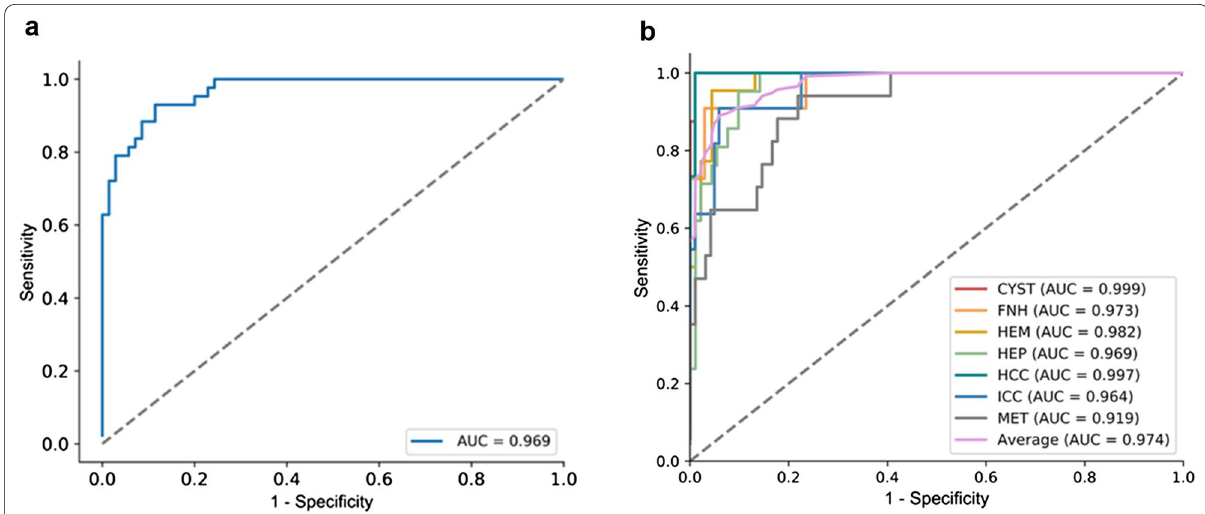
Fig. 2 ROC curves of the ( a ) two‑way and ( b ) seven‑way deep learning model classification